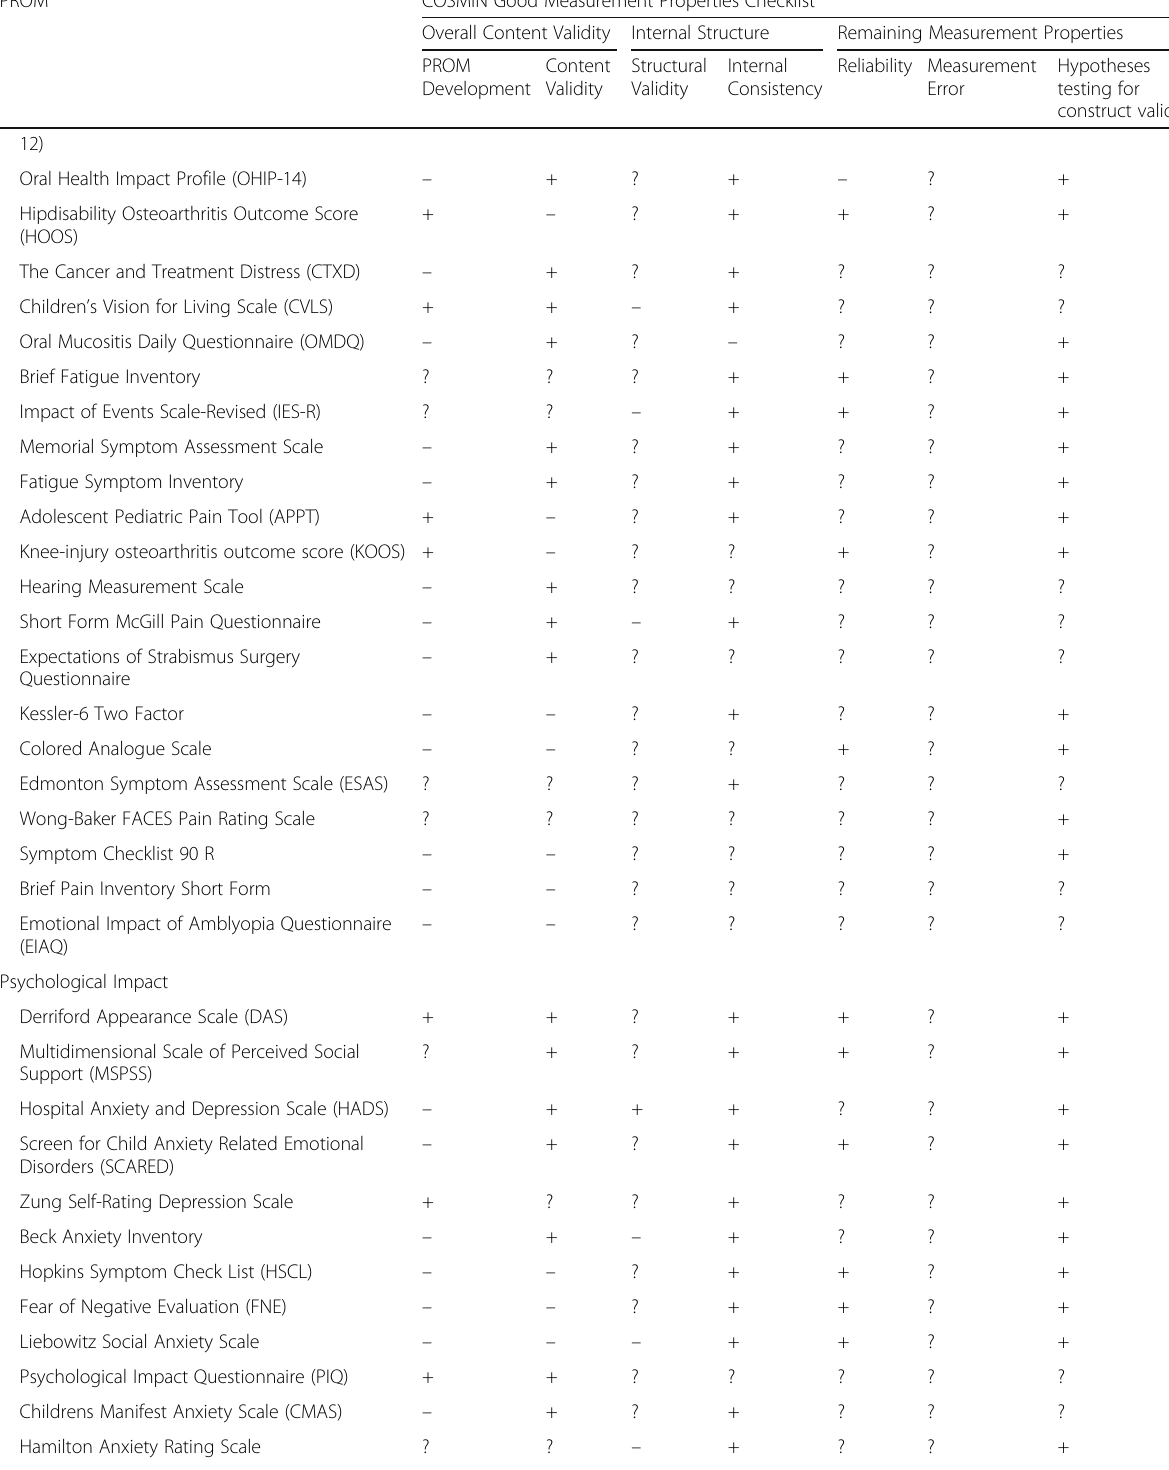
Table 1 Quality analysis of all identified PROMs ( n = 100). The COSMIN ‘ good property checklist ’ was applied on 100 PROMs, across 7 measurement properties stratified by construct. PROMs were ranked highest score of sufficient quality to lowest, within a construct. ‘ + ’ indicates a score of sufficient quality, ‘ ? ’ indicates that the specific measurement property was not reported on, and ‘ - ’